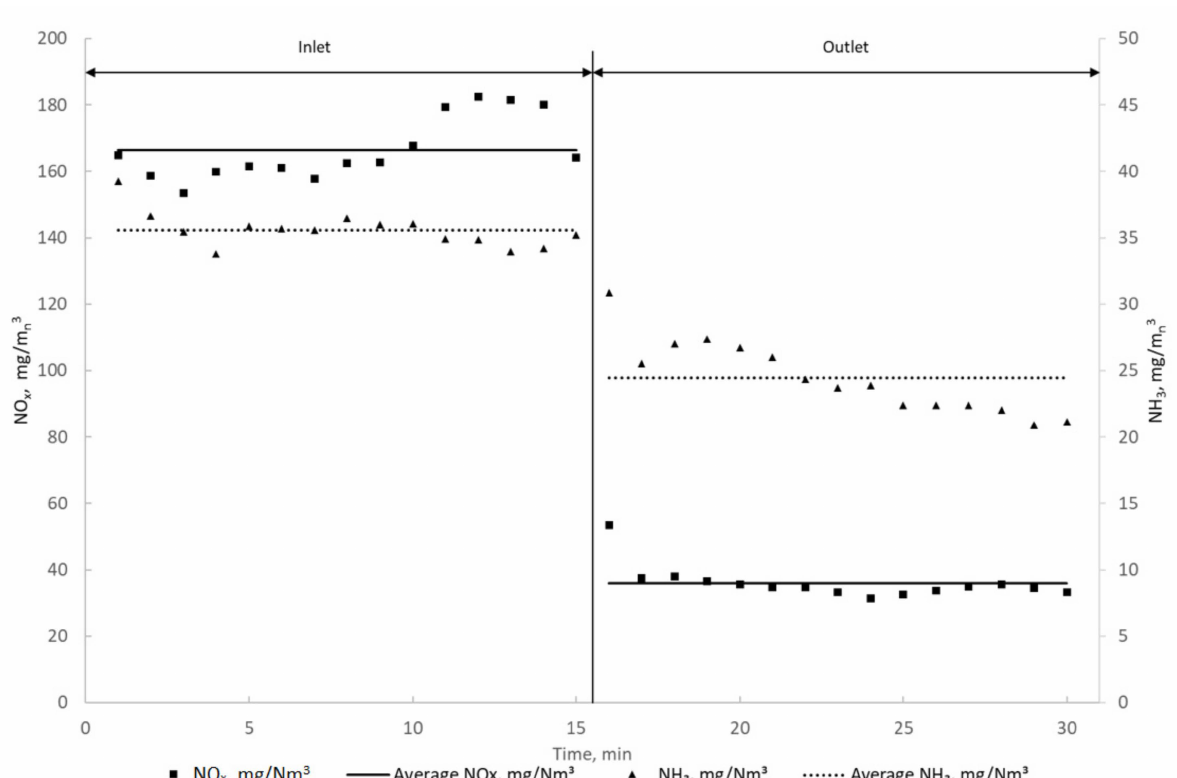
Figure 7. Emissions measured at the inlet and outlet of the new catalyst CN at an average power of 18.5 MW th -flue gas temperature approx. 300 ◦